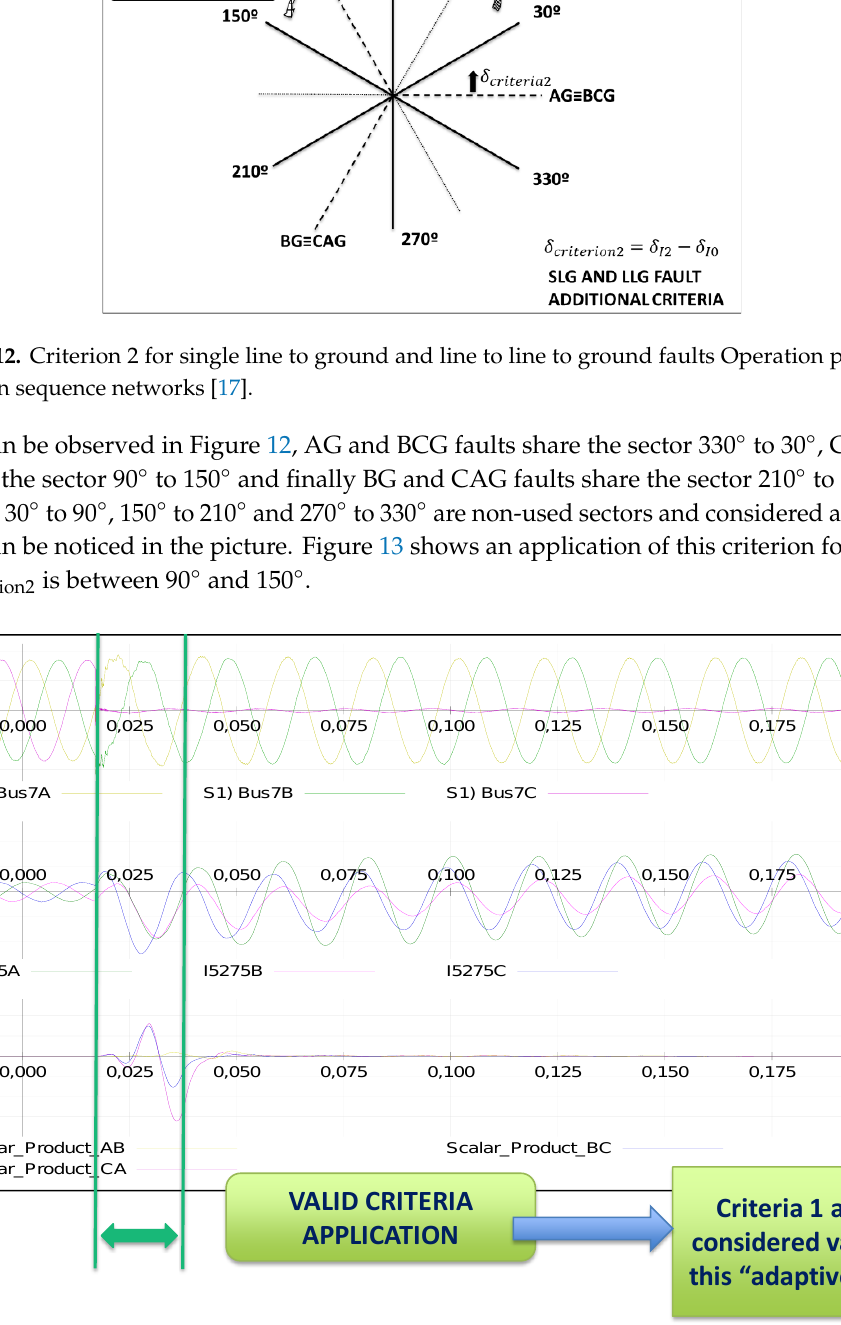
( b ) Figure 11. Criterion 1 for single line to ground and line to line to ground faults ( a ) and line to line faults ( b ). 4.3. Criterion 2. Negative vs. Zero Sequence Currents Criterion 2 is based on the comparison between negative and zero sequence currents [17]. This criterion, although is only valid for grounded faults, provides the advantage that adjacent sectors in criterion 1 are delayed 120° in criterion 2, avoiding wrong faulted phase detection, providing an